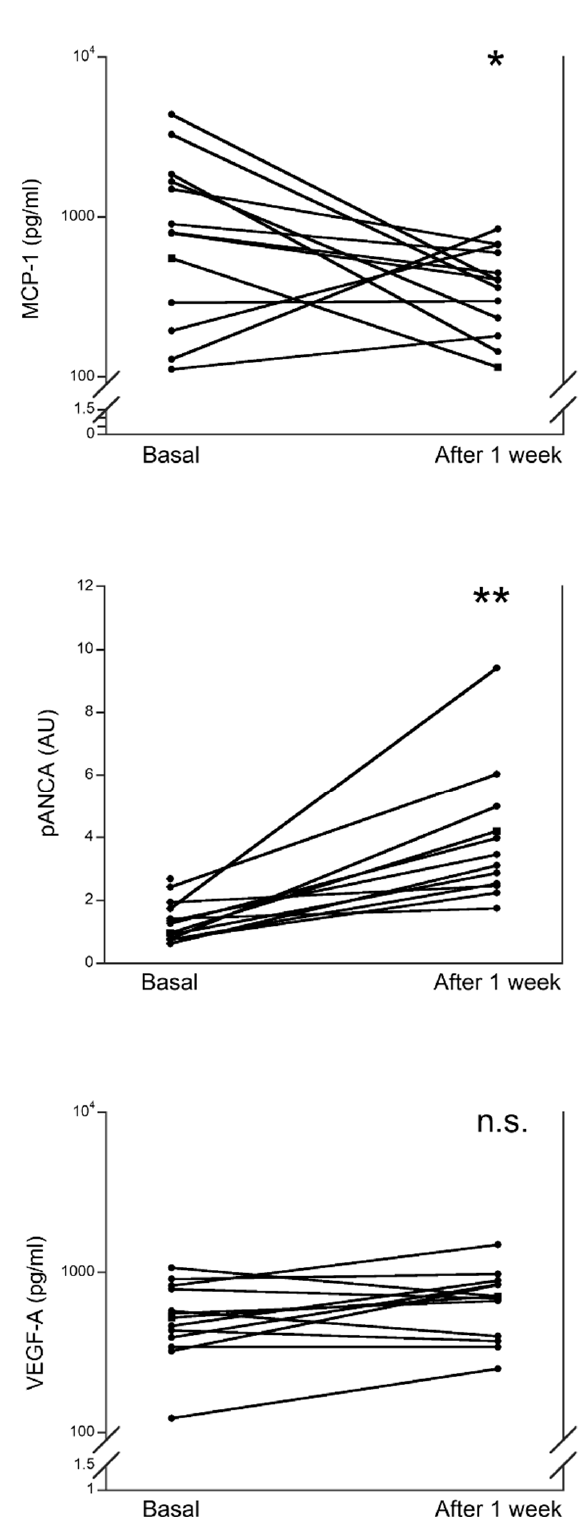
Figure 2. Comparison of serum levels of MCP-1, pANCA, and VEGF-A in patients with MIS-C at hospital admission and after one week of hospitalization. * p < 0.01; ** p < 0.001; n.s.: not significant.